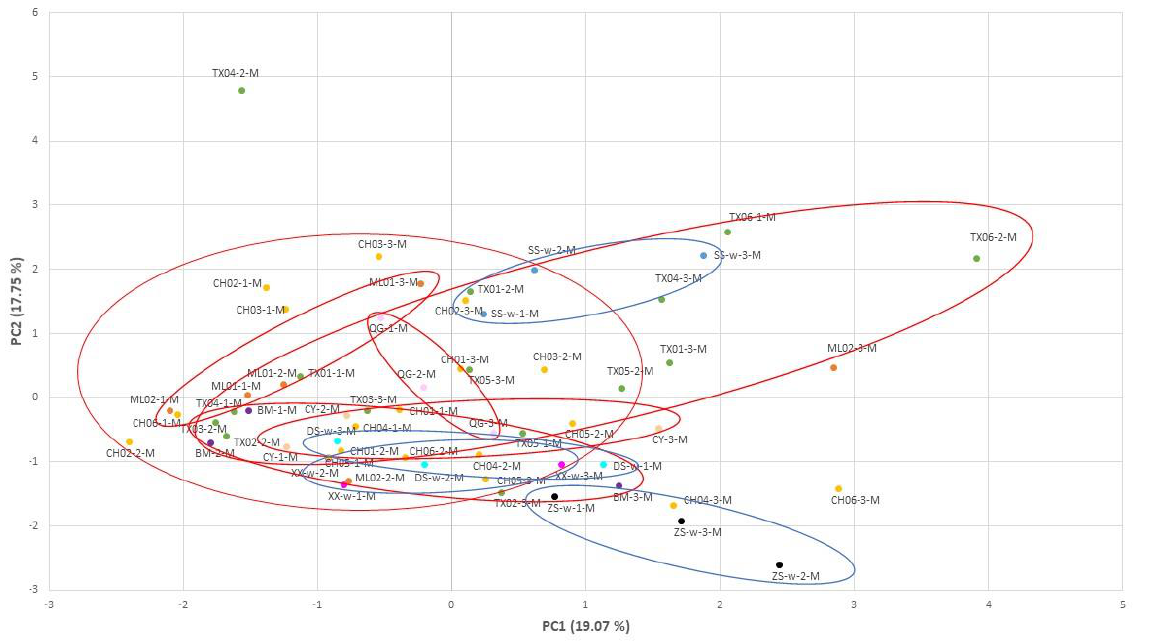
Figure 6. Principal component analysis (PCA) in the middle site of the shells: PCA plotted against the PC1 vs. PC2 axes. Different color of points in the figure means different locations.